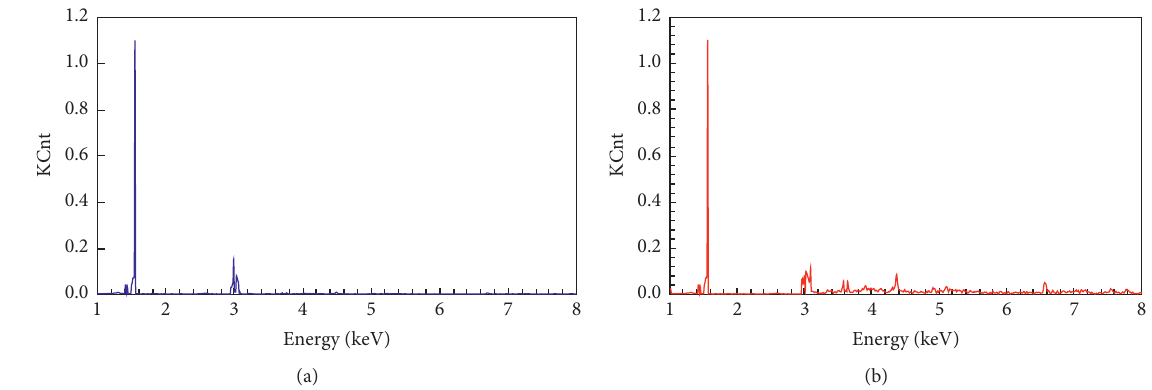
Figure 4: EDX spectrum of the synthesized BCPE-AgNPs ( a ) and APE-AgNPs (b).